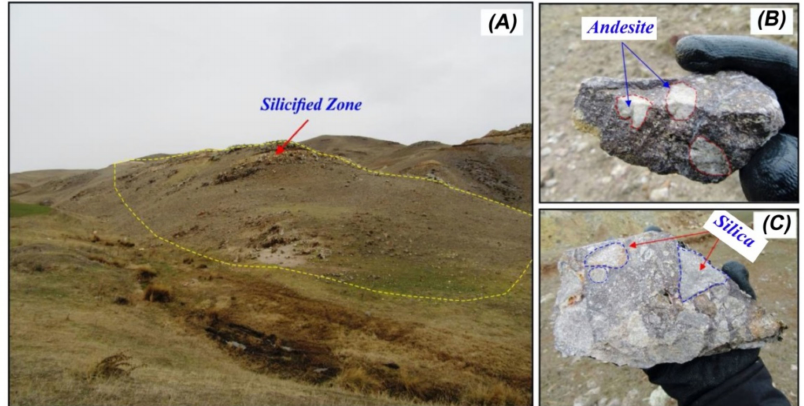
Figure 17. Silicified zone in the Noghdouz gold mineralization area. ( A ) Regional view of Silicified zone; ( B ) Close view of breccia textures in a hand specimen of the andesitic host rock; ( C ) View of silica clasts in a hand specimen of the breccia